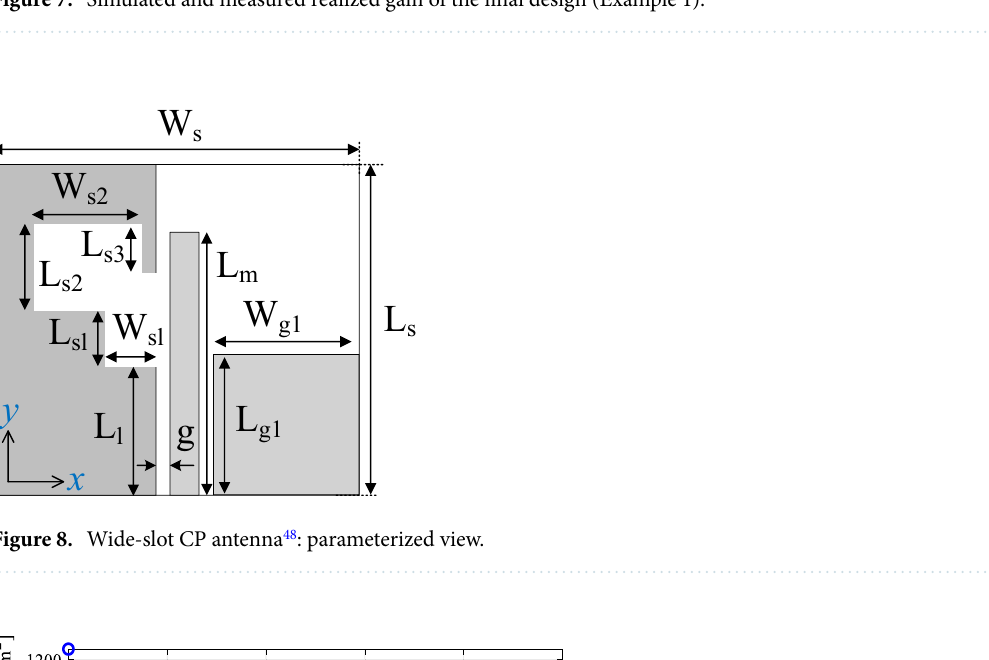
Figure 7. Simulated and measured realized gain of the final design (Example 1).